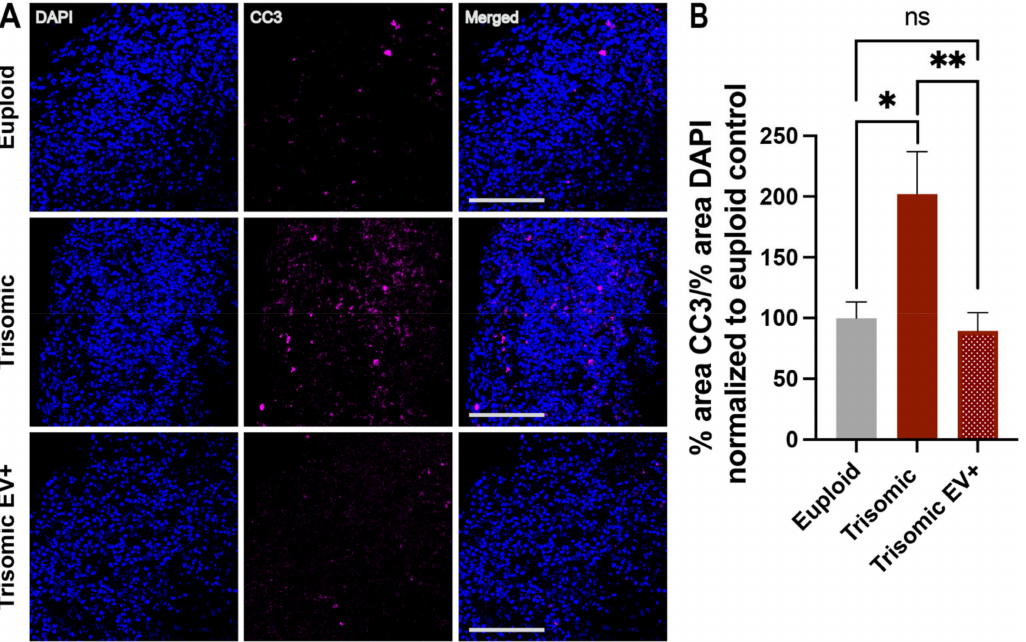
Figure 5. The extent of cell death is reduced in trisomic CS treated with EVs. ( A ) Single and merged channels of confocal images showing DAPI staining with IHC labeling of CC3 (magenta) in euploid and trisomic untreated and EV-treated CS generated from isogenic cell lines. Scale bar = 100 µ m. ( B ) Bar graph showing the quantification of percentage of CC3 expression in euploid CS and trisomic untreated and EV-treated CS, quantified as the ratio of the area occupied by CC3 to the area occupied by DAPI and then normalized to the euploid control that was calculated as 100% for each indepen- dent experiment. The quantification was performed through particle analysis via ImageJ; euploid n = 18; trisomic n = 22; trisomic EV+ n = 22 CS per group. These graphs display results from three independent experiments. Statistical analysis performed via unpaired t -test with Welch’s correction comparing all three groups to each other. Results are shown as mean ± SE.* p < 0.05, ** p < 0.01, ns =